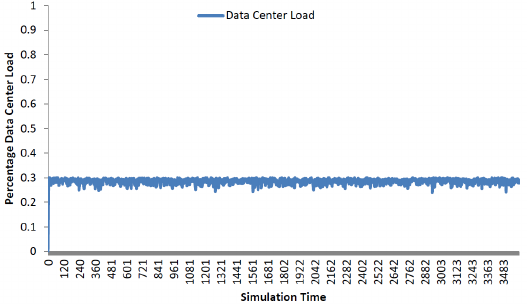
Figure 2. Average Data Center